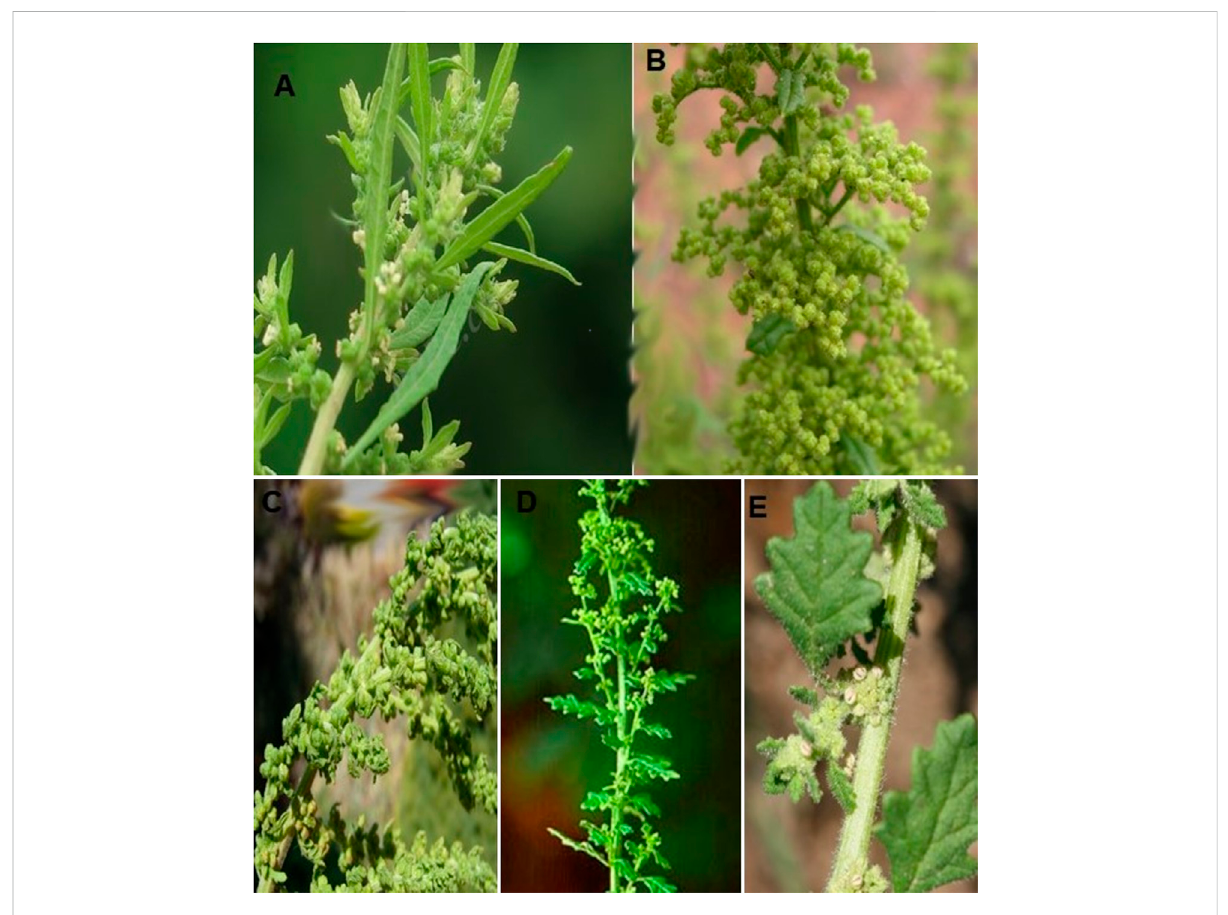
FIGURE 2 Dysphania species. (A) D. ambrosioides , (B) D. botrys , (C) D. muti fi da , (D) D. schraderiana , (E) D. pumilio .